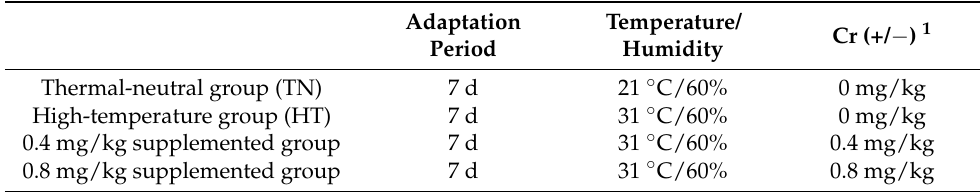
Table 2. Treatment group design.